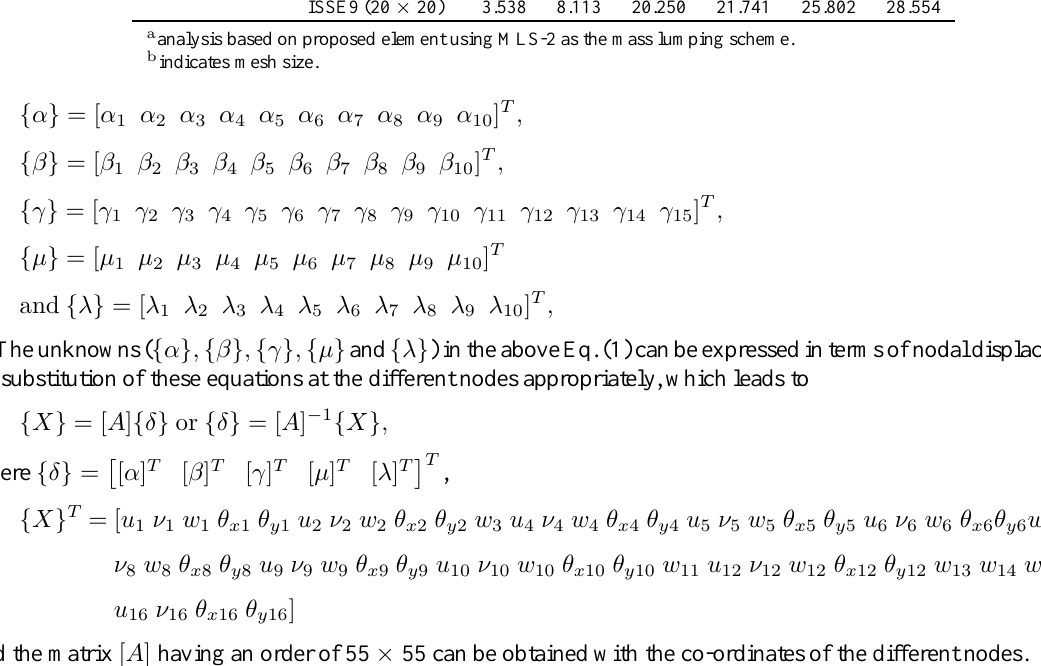
Frequency parameters ( ωa 2